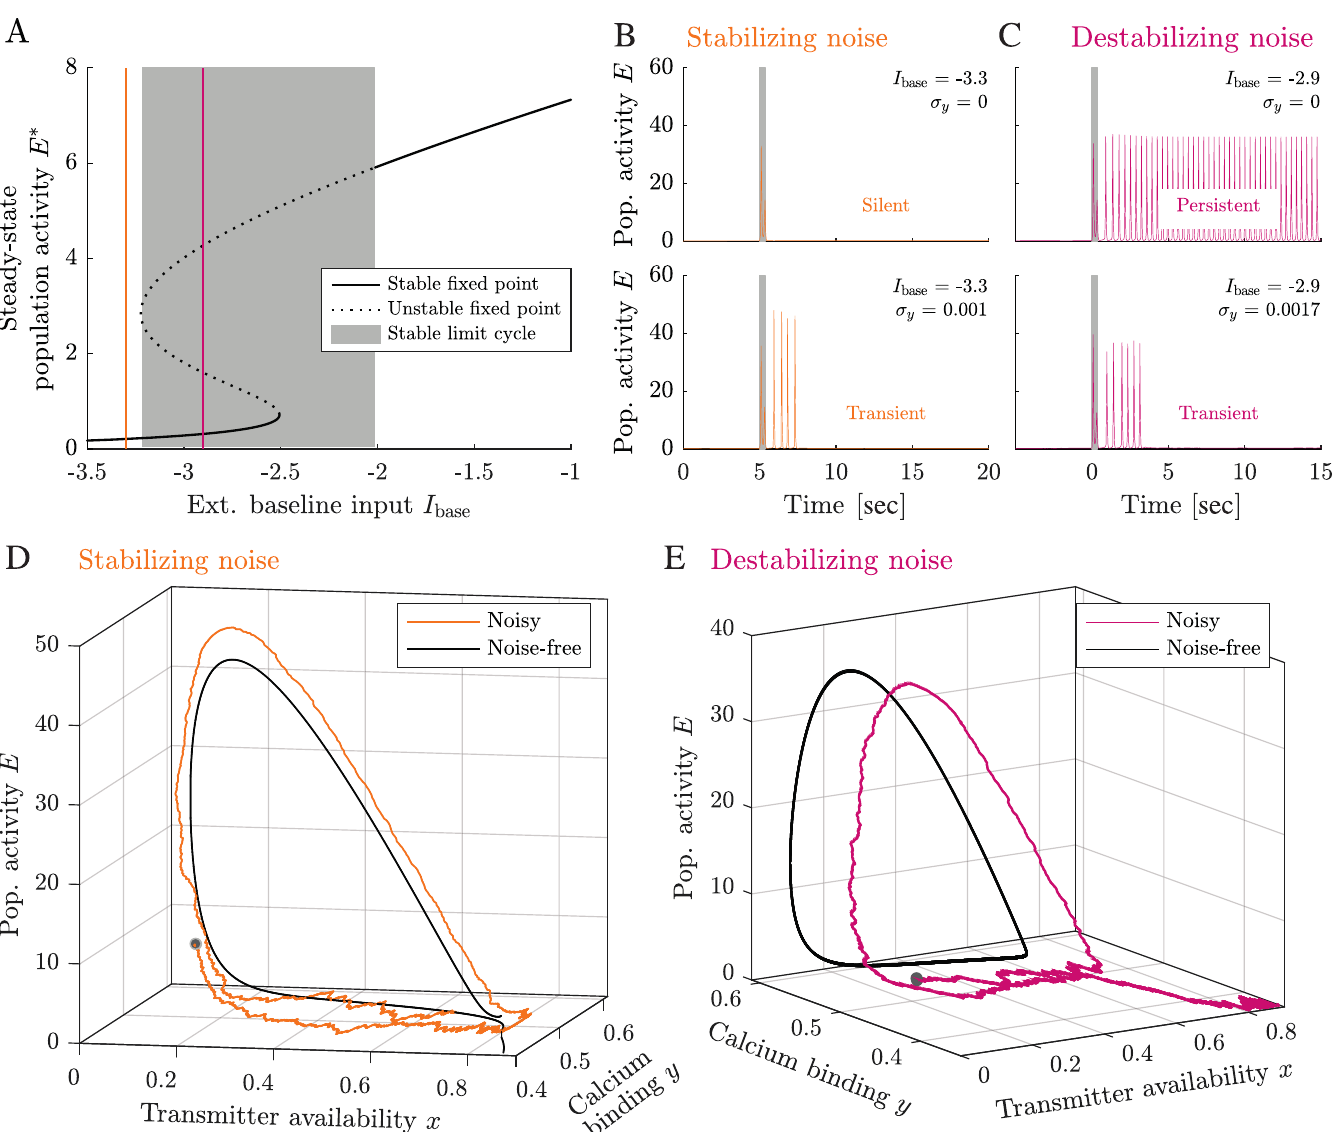
Fig 3. Noise can turn activity-silent and persistent firing regimes into transient WM activity. A Bifurcation diagram for a STP rate network without LPA signaling. The grey-shaded area denotes the regime in which a stable limit cycle exists. Presenting a sufficiently strong WM cue to silent networks in the bistable regime evokes persistent WM activity. B-C Population activity for two rate network simulations in the silent and the persistent regime, with and without noise (of amplitude σ to the synaptic variable y . The grey shaded area denotes the cue stimulus. In the silent regime ( E < − 3.25), noise can stabilize a ‘ghost’ of a limit cycle [56] (‘stabilizing noise’). In the regime of persistent limit cycles, noise can disrupt oscillations (‘destabilizing noise’). D-E Typical trajectories of transient limit cycles emerging from stabilizing (orange line, D) and destabilizing noise effects (magenta line,E) at baseline input levels I base = -3.3 (left) and I base = -2.9 (right). Black lines show a representative example of a noise-free trajectory (left) and the limit cycle (right). Remaining rate network parameters: see Table D in S1 Text.